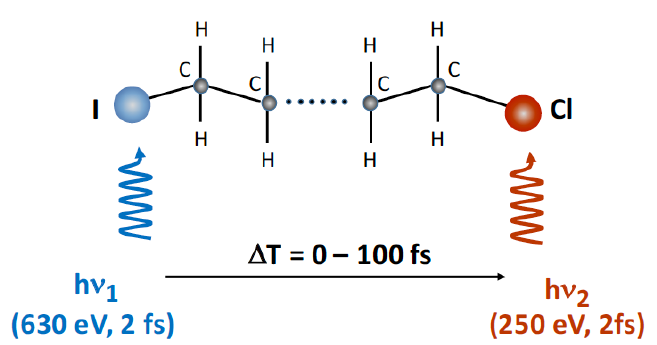
Figure 3. Schematic representation of the two-color pump–probe process in molecular IC n H 2n Cl. The pump pulse with photon energy h ν 1 (630 eV) is ionizing selectively the 3 d shell in the iodine atom. The subsequent electronic relaxation and charge migration is monitored with the probe pulse h ν 2 (250 eV) of variable temporal delay ∆ T between both pulses via selective ionization in the 2 p shell of the chlorine atom and the corresponding Auger decay. Typical pulse durations for pump and probe pulses are in the order of 2